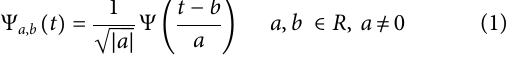
Frontiers in Materials |